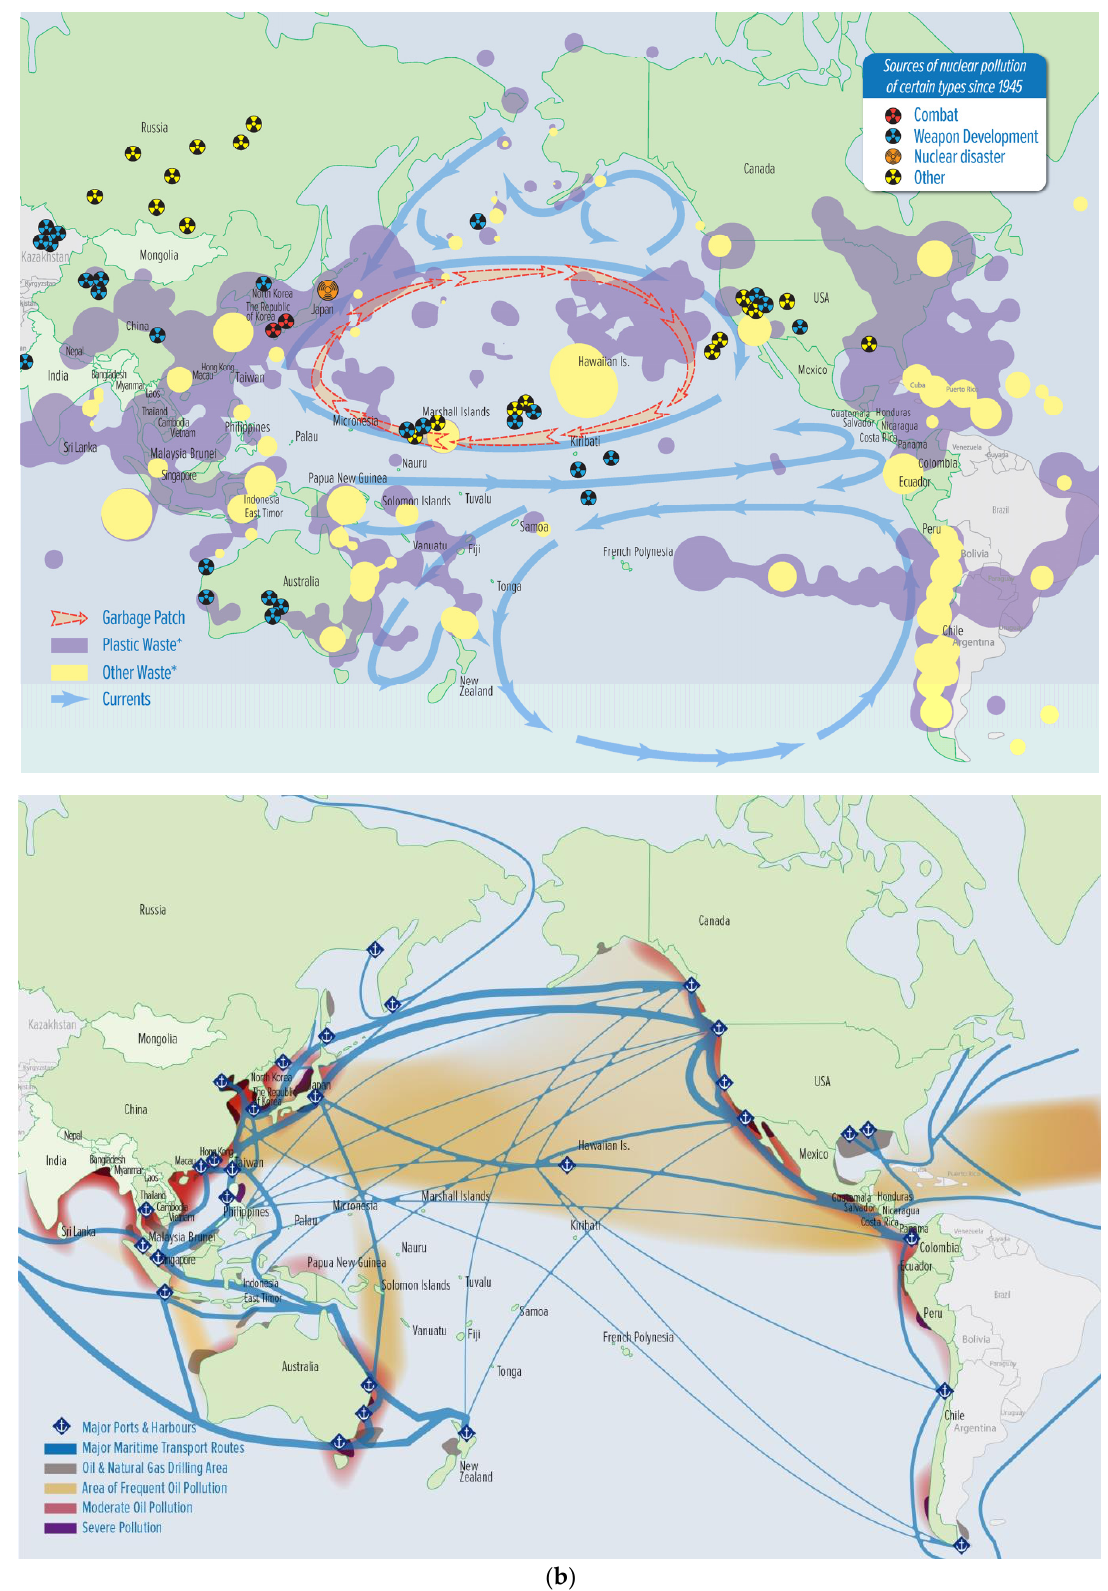
Figure 3. Human activities affect the environment by contributing to the pollution. ( a ) Waste pollution [56], nuclear pollution [57,58], garbage patch [59]. ( b ) Shipping and oil pollutions [60–65] *.